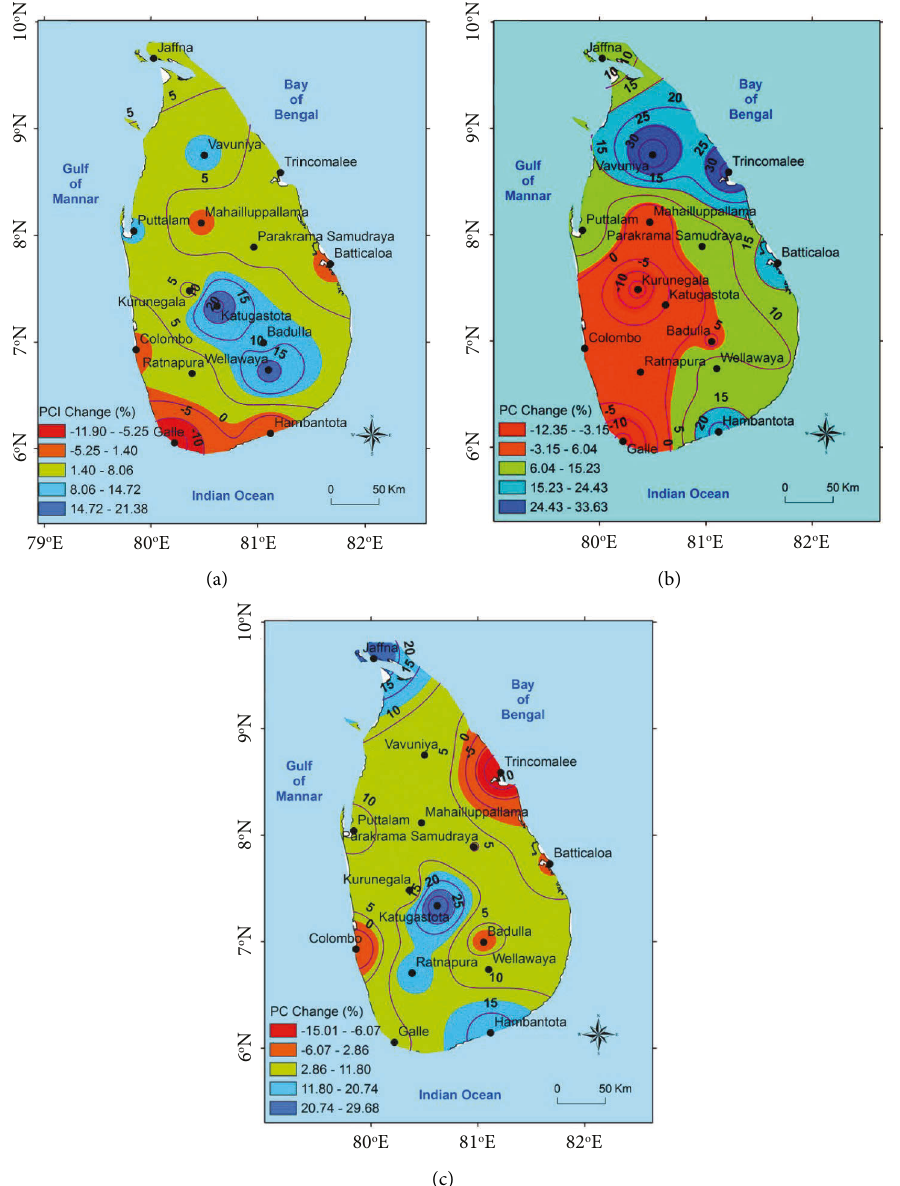
Figure 7: Spatial distribution of annual and seasonal change in PCI in Sri Lanka. (a) For annual PCI change. (b) For SWM PCI change. (c) For NEM PCI